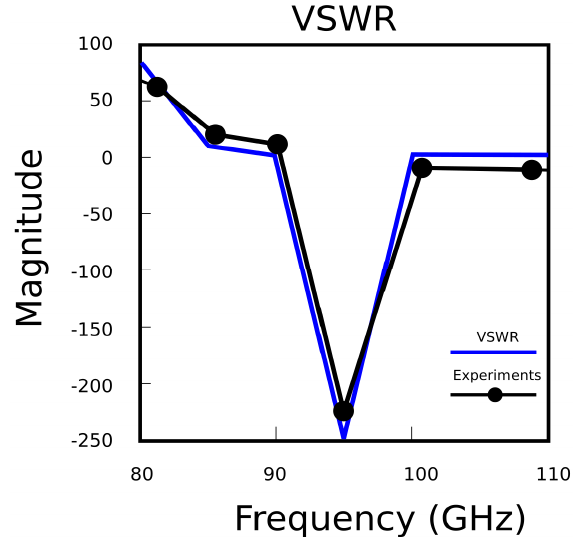
Figure 21. Graphical representation of simulated and measured VSWR.